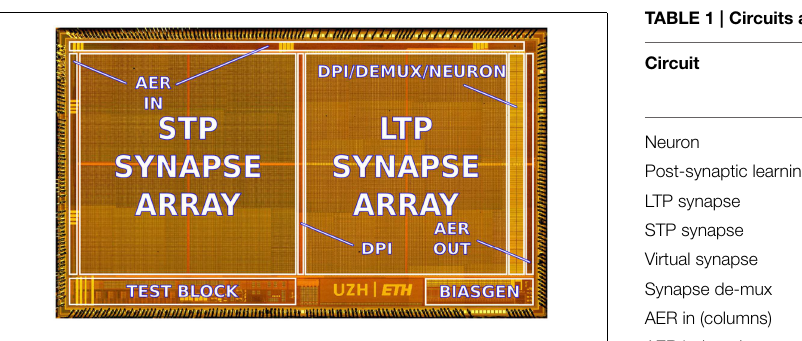
FIGURE 2 | Micro-photograph of the ROLLS neuromorphic processor. The chip was fabricated using a 180nm CMOS process and occupies an area of 51.4mm 2 , comprising 12.2 million transistors.